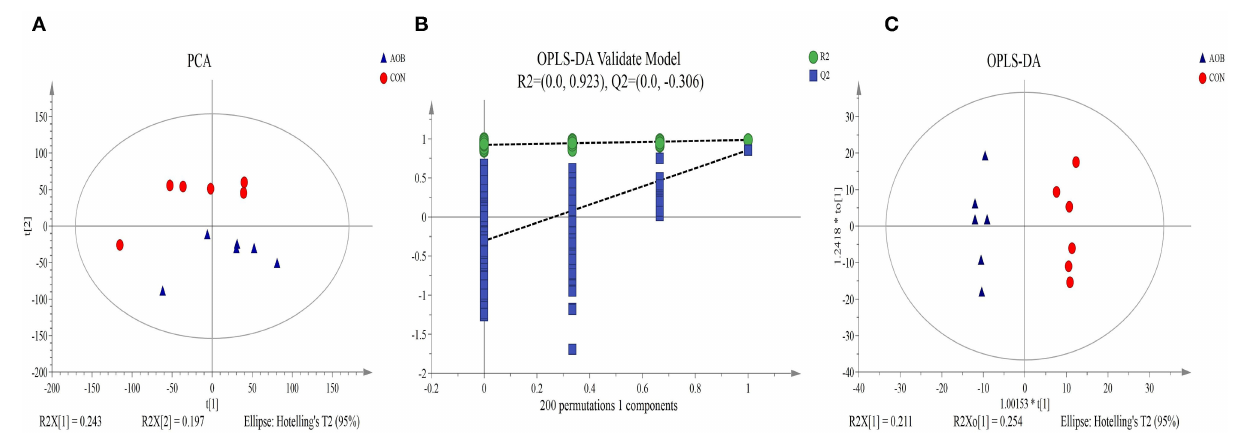
FIGURE 5 | Principal component analysis (PCA) score plot (A) , permutation test plot (B) , and orthogonal partial least-square discriminant analysis (OPLS-DA) (C) of the CON and AOB groups based on the milk metabolites profiles. The percentage variation in the plotted principal components is marked on the axes. Each spot represents one sample, and each group of milk samples is indicated by a different color. CON, red circle; AOB, blue triangle.